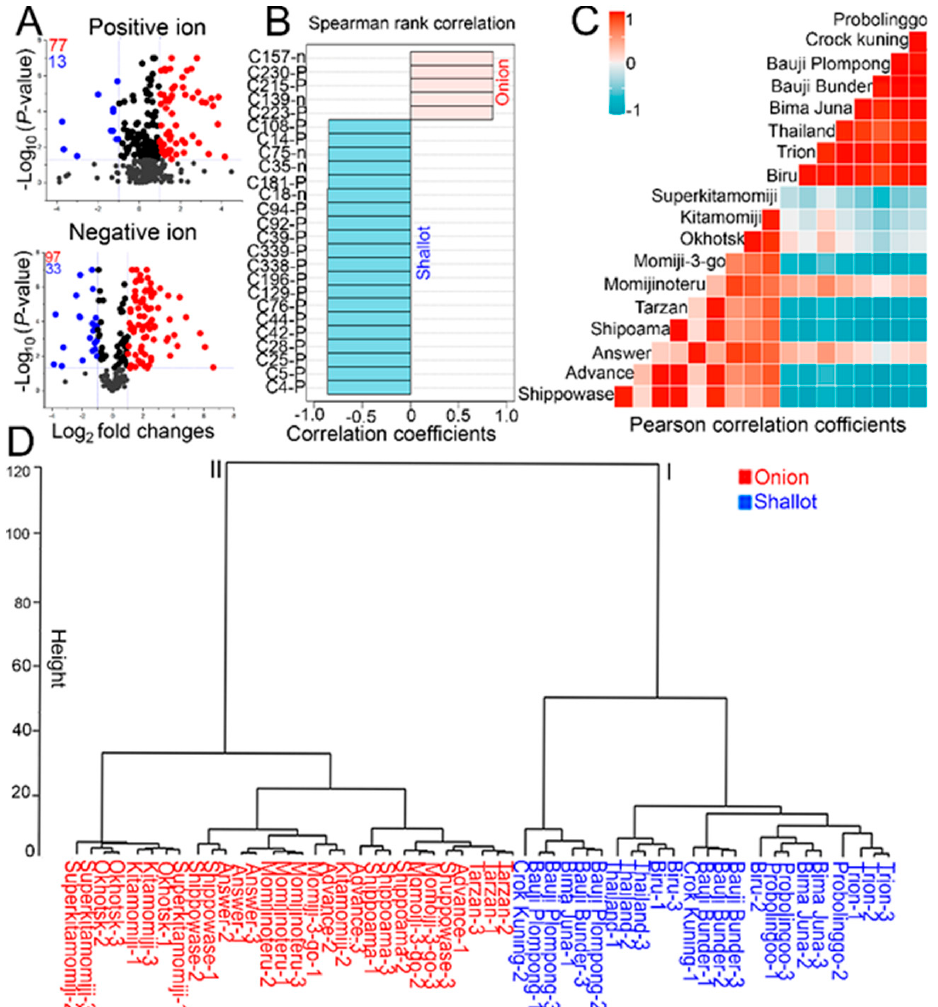
Figure 2. Metabolite profiles and correlation analyses of 10 Japanese bulb onion cultivars and 8 Indonesian landraces. ( A ) Volcano plots of the di ff erentially produced metabolites (DPMs) in the examined bulb onion and shallot samples by positive and negative ion modes of LC–Q-TOF-MS. Red and blue numbers indicate increased (FC ≥ 2.0; p < 0.05) and decreased (FC ≤ 0.5; p < 0.05) metabolites in the shallot / onion comparison, respectively. ( B ) Top 25 metabolites that exhibited a strong positive correlation with shallots and bulb onions based on Spearman’s rank correlation. ( C )